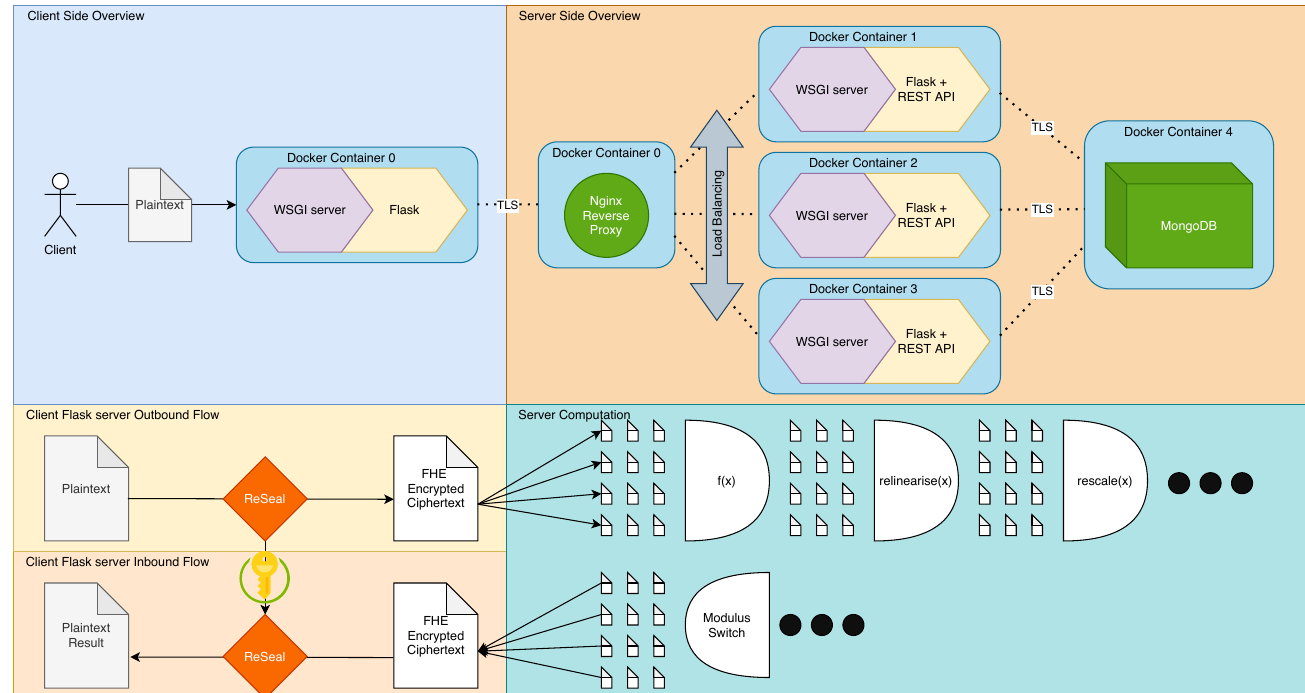
Figure 1. The pipeline demonstrates the key stages of our project, from the client and raw data ( upper left ) to the data processing and analytics ( lower right